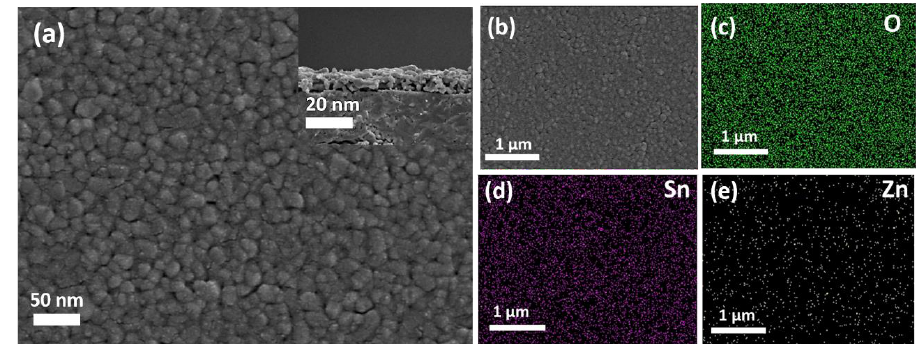
Figure 2. ( a ) FESEM for SnO 2 /ZnO heterostructures (Inset: cross-section view), ( b – e ) EDS mapping with elements for O, Sn, and Zn.